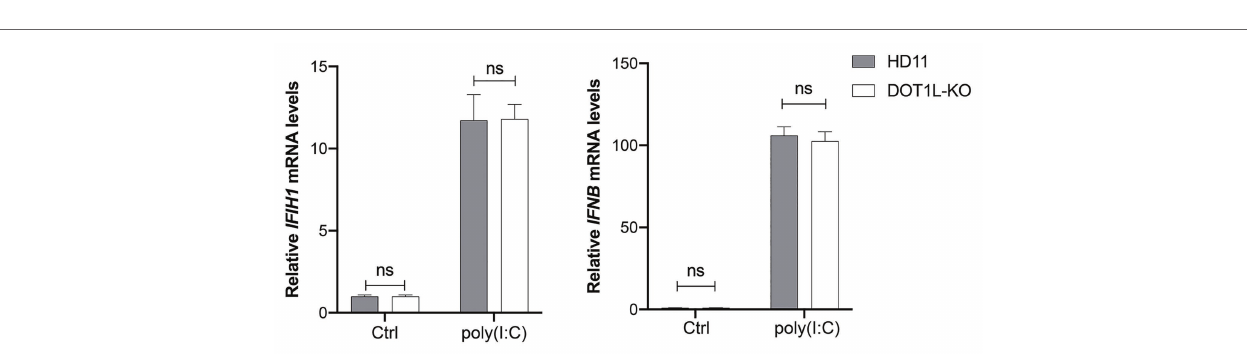
(H3K79me1/2/3). Genome-wide ChIP-seq analysis indicated that